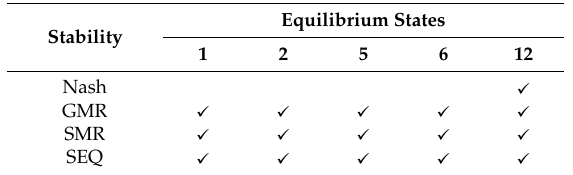
Figure 5. Evolution of the conflict from the status quo through an intermediate state to the final resolution.